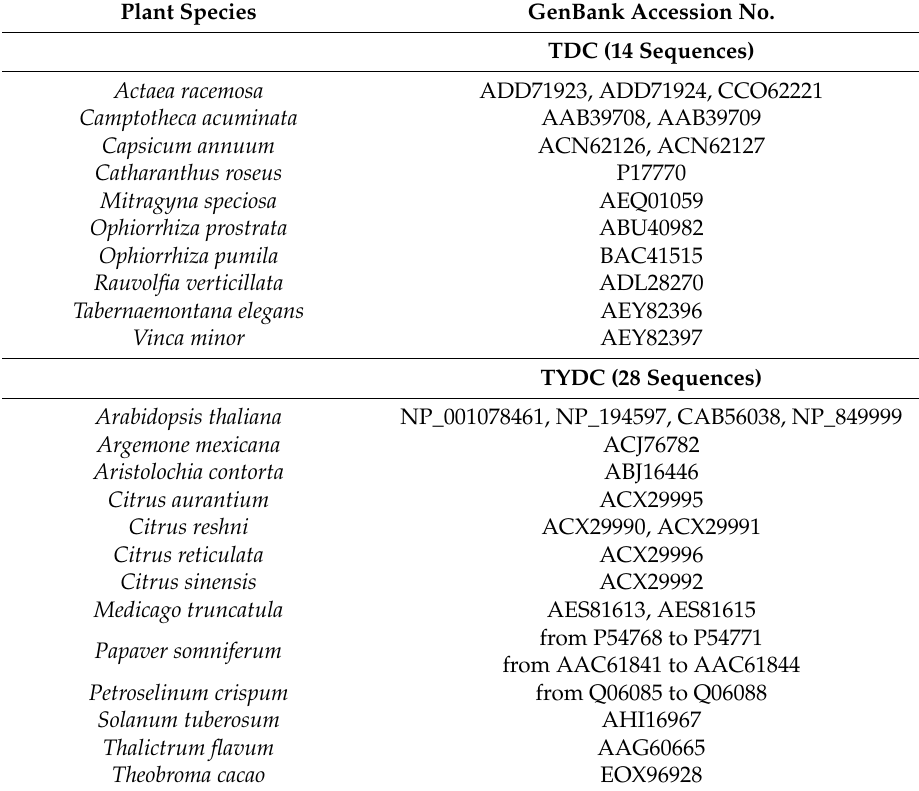
Table 1. The 42 plant TDC/TYDC sequences retrieved from NCBI and listed by plant